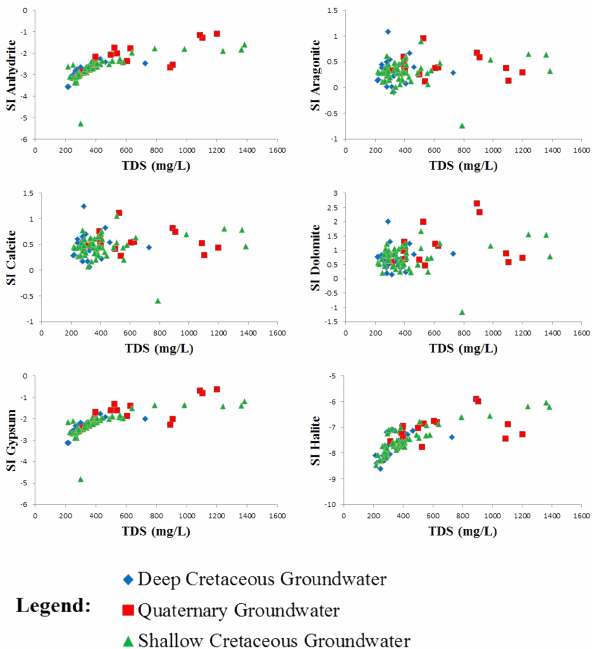
Figure 10. Plots of saturation indices with respect to some minerals in